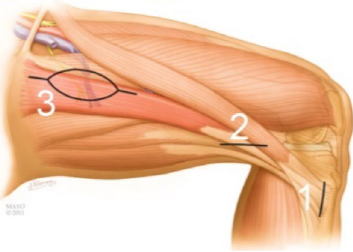
Figure 6. Three incisions made to harvest the gracilis. (1) Longitudinal incision made over the pes anserine . (2) Distal medial thigh incision at a length of the musculotendon junction. (3) Proximal medial thigh incision. (Printed with permission of the Mayo Foundation for Medical Education and Research. All rights reserved, copyright